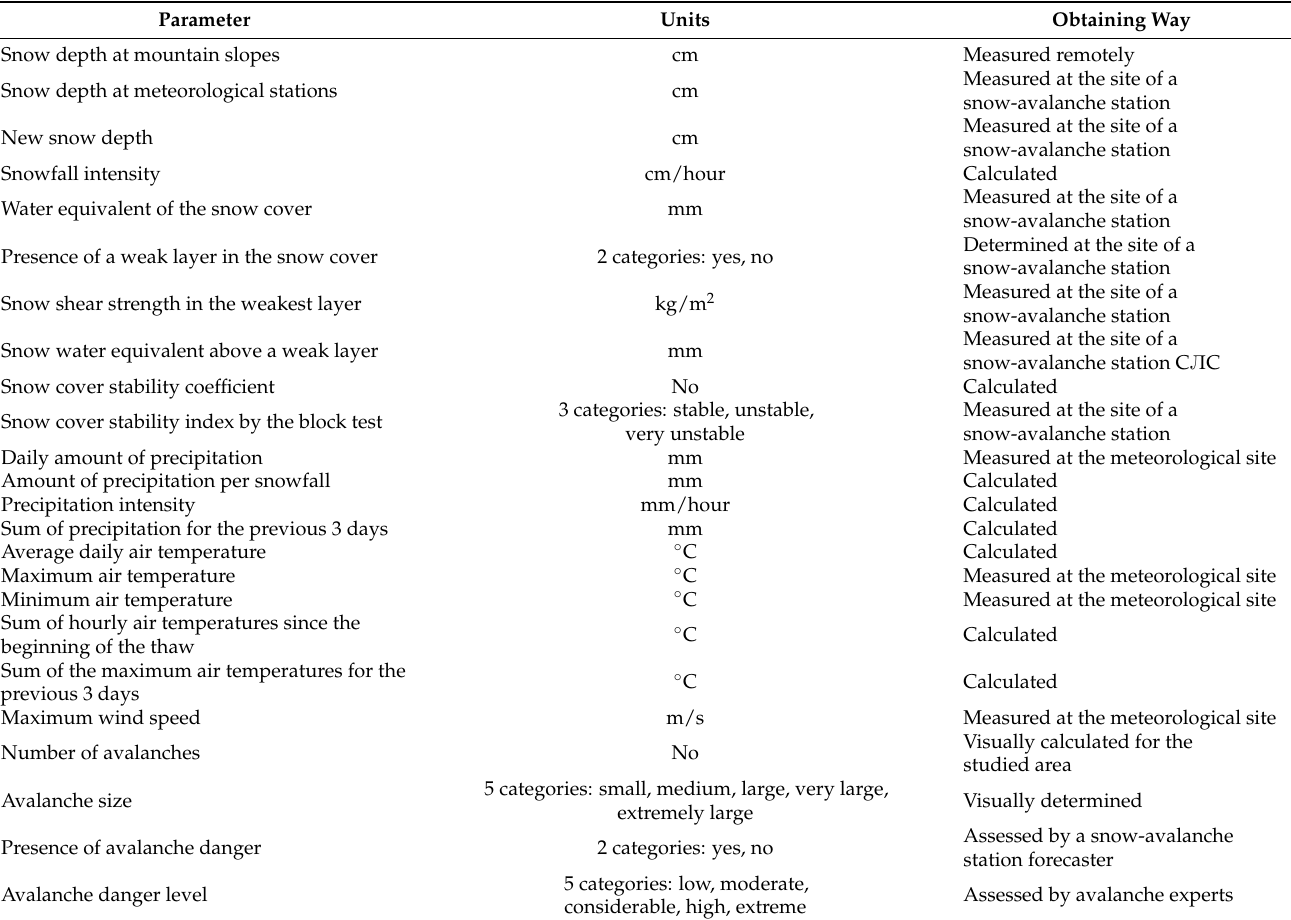
Table 1. The list of the database